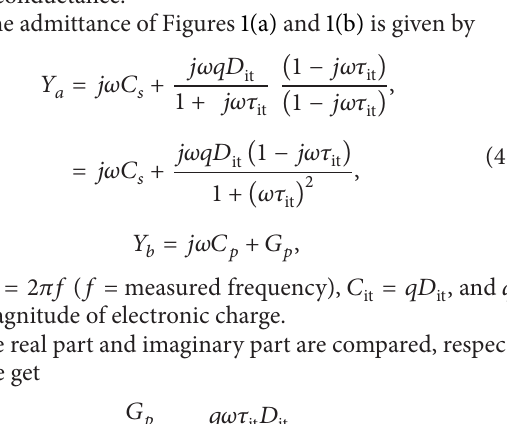
Figure 1: Equivalent circuits for conductance measurements; (a) MOS- 𝐶 with interface trap time constant 𝜏 of (a), and (c) measured